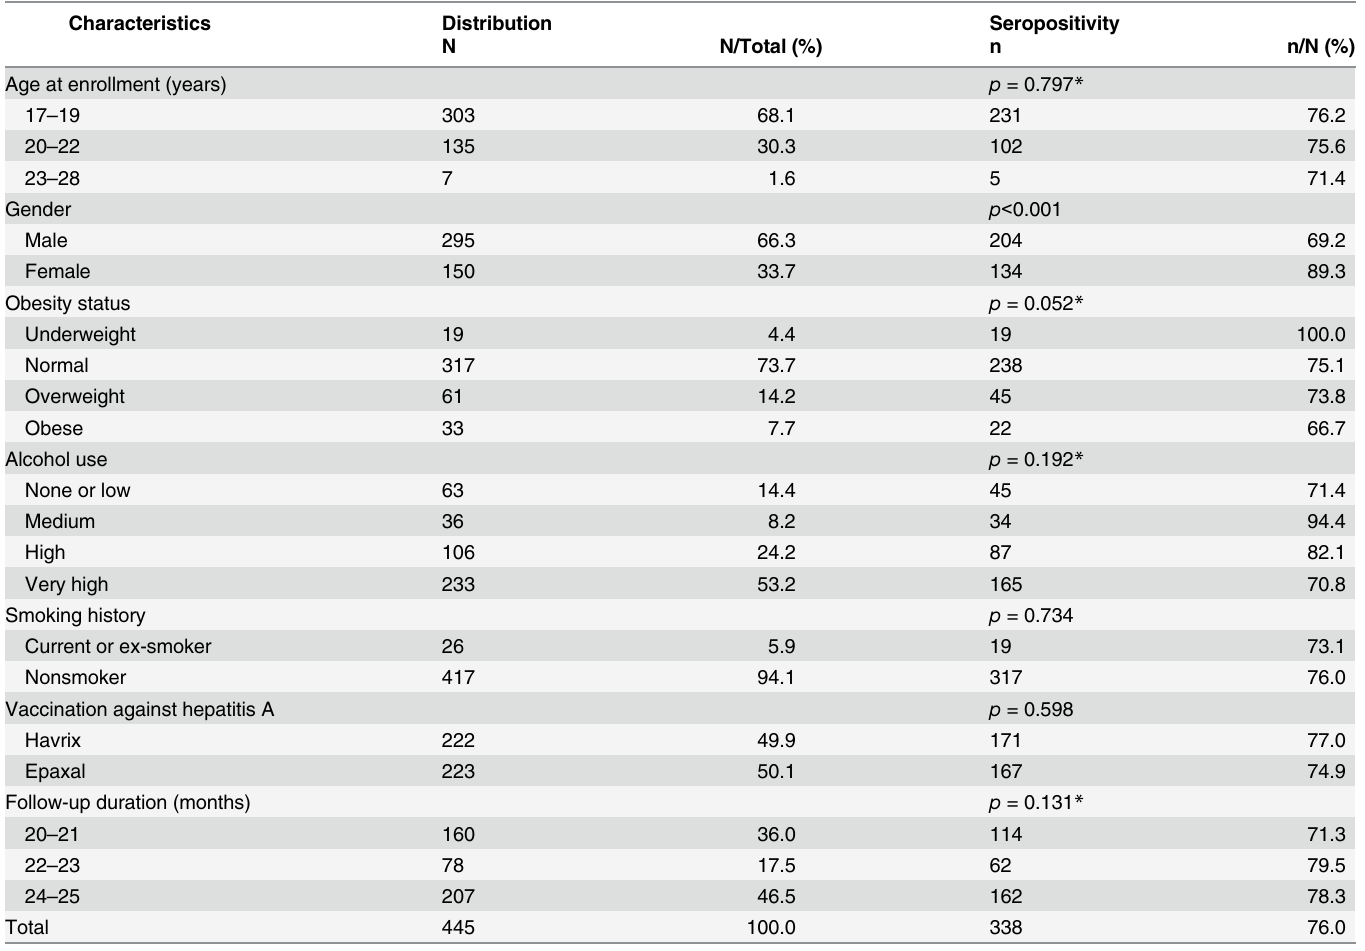
Table 1. Characteristics of study participants and related factors for